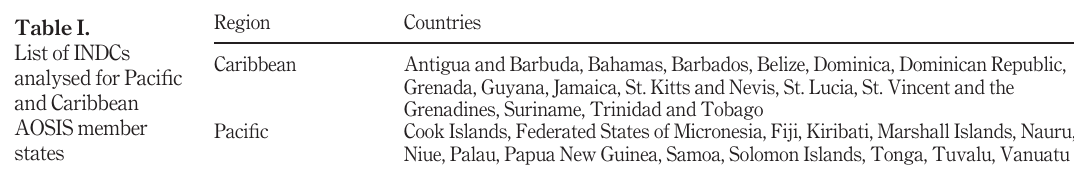
analysed for Paci fi c and Caribbean AOSIS member